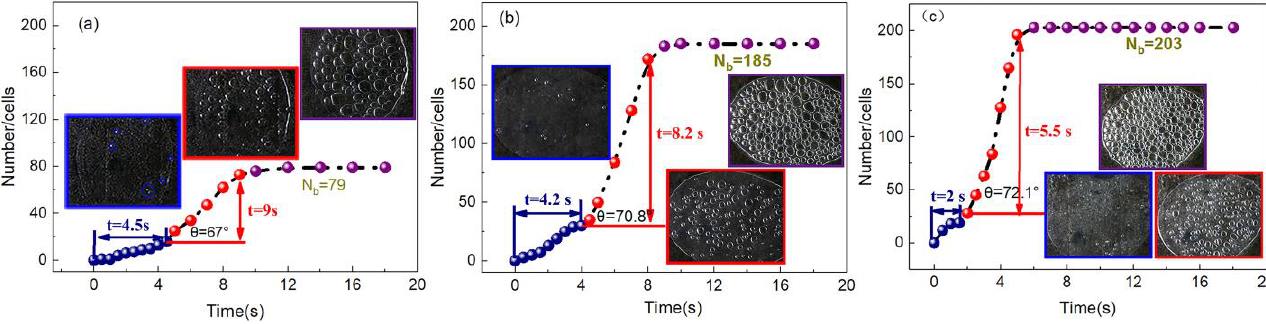
Figure 7. The n - t curves under different foaming agent contents: ( a ) 0.5 wt.%, ( b ) 0.6 wt.%, ( c ) 0.7 wt.%.